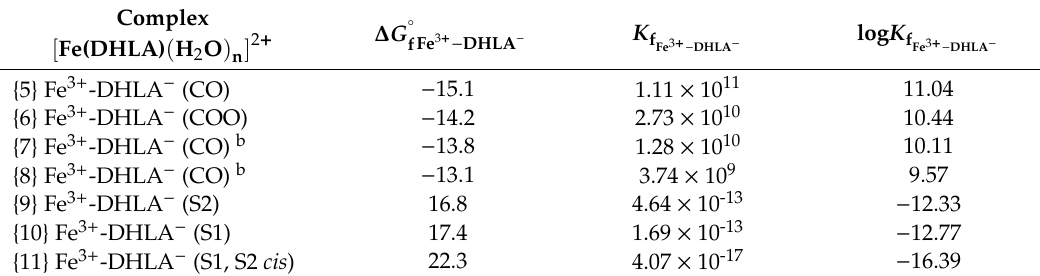
Table 2. Standard Gibbs free energy change ( ∆ G the chelation of Fe(III) with dihydrolipoic acid, DHLA − , (as per Equation (5)) in aqueous solution at 298.15 K. a